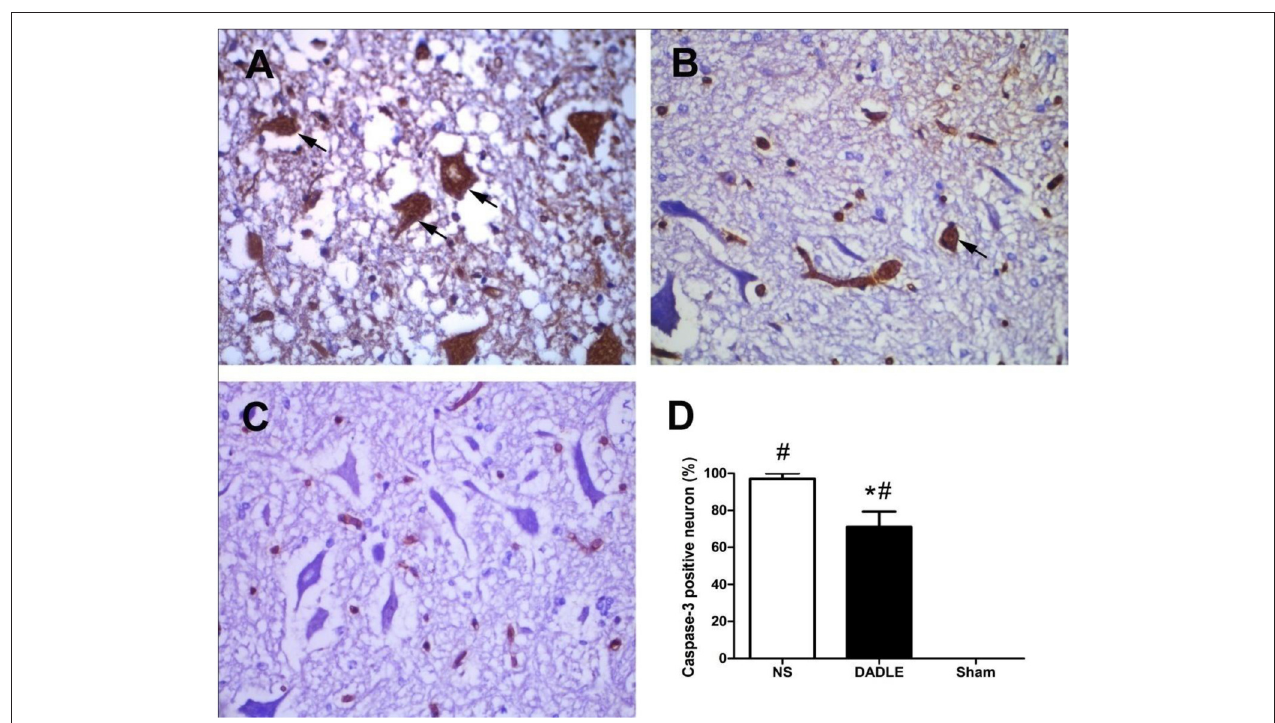
FIGURE 3 | Immunohistochemical staining of spinal cords using caspase-3 antibody at 48h after reperfusion. The samples of spinal cords were harvested from the spinal cord I/R and sham rabbits at 48h after operation. Neurons in Group NS contained intense caspase-3 immunoreactivity (A) , which was significantly attenuated in Group DADLE (B) , while normal spinal cords stained poorly with caspase-3 in Group Sham (C) . Comparison of percentage of caspase-3 positive neuron in each high power field (D). Bars represent mean ± SD ( n = 6–8). * P < 0.05 vs. the NS group. # P < 0.05 vs. the Sham group. The arrows indicate caspase-3 positive cells.